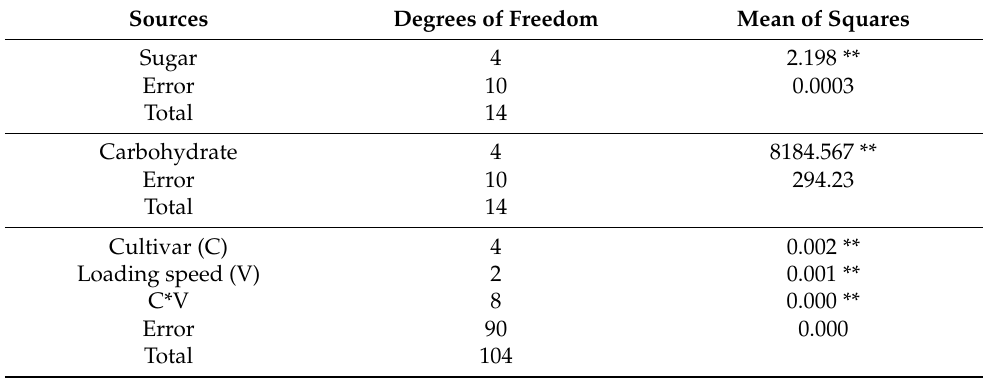
Table 1. Analysis of variance of chemical and mechanical parameters of potato cultivars. Sources Degrees of Freedom Mean of Squares Sugar 4 2.198 ** Error 10 0.0003 Total 14 Carbohydrate 4 8184.567 ** Error 10 294.23 Total 14 Cultivar (C) 4